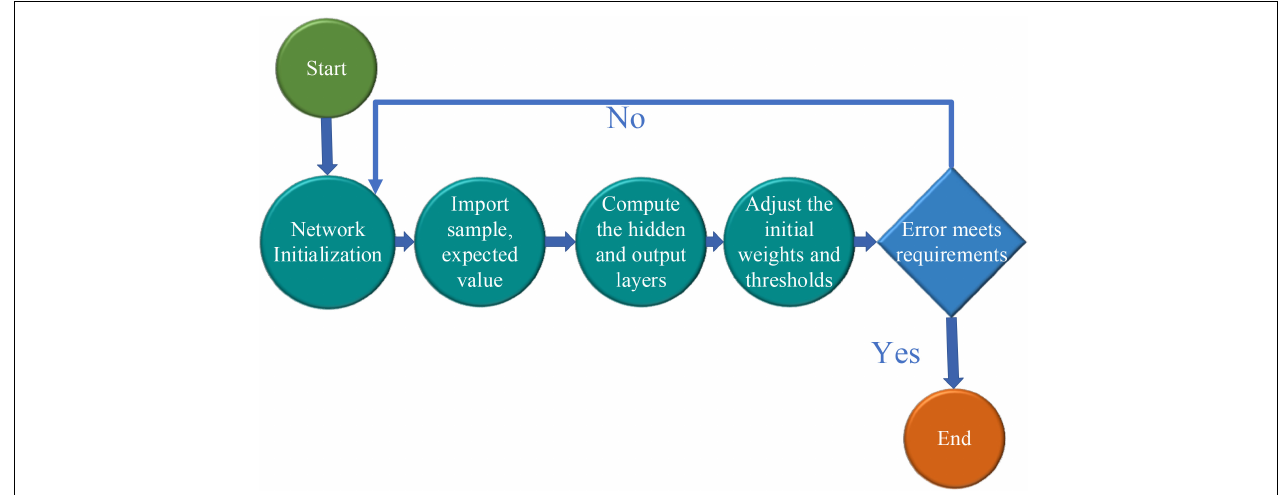
FIGURE 5 | Learning and training of the three-layer BPNN